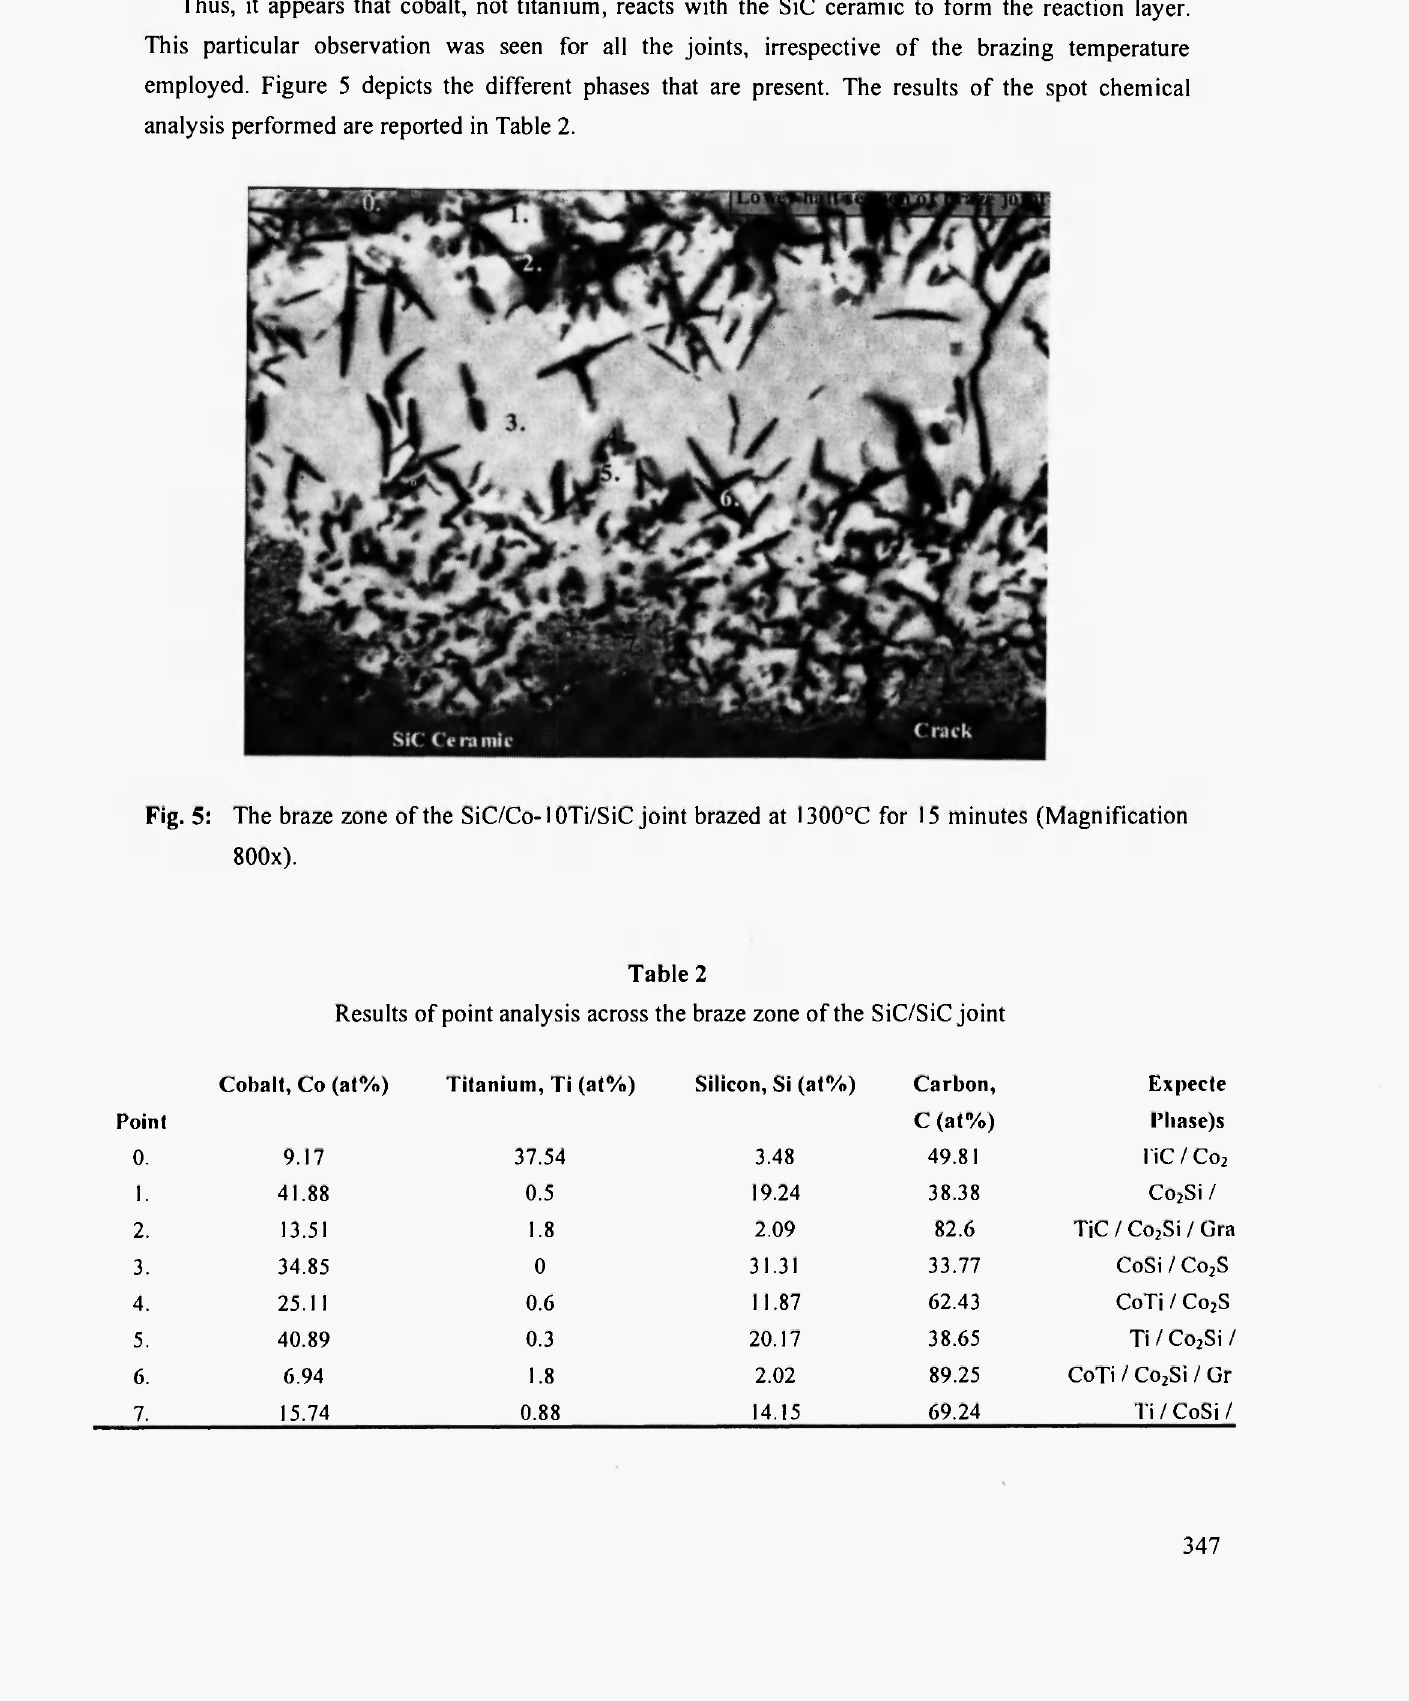
Fig. 5: The braze zone of the SiC/Co-10Ti/SiC joint brazed at 1300°C for 15 minutes (Magnification